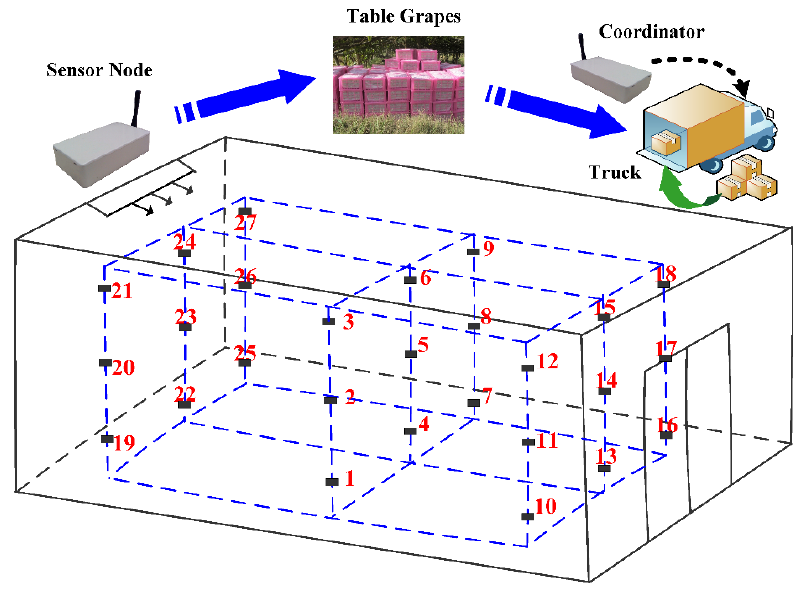
Figure 3. The sensor nodes and coordinator deployment at the refrigerated truck.